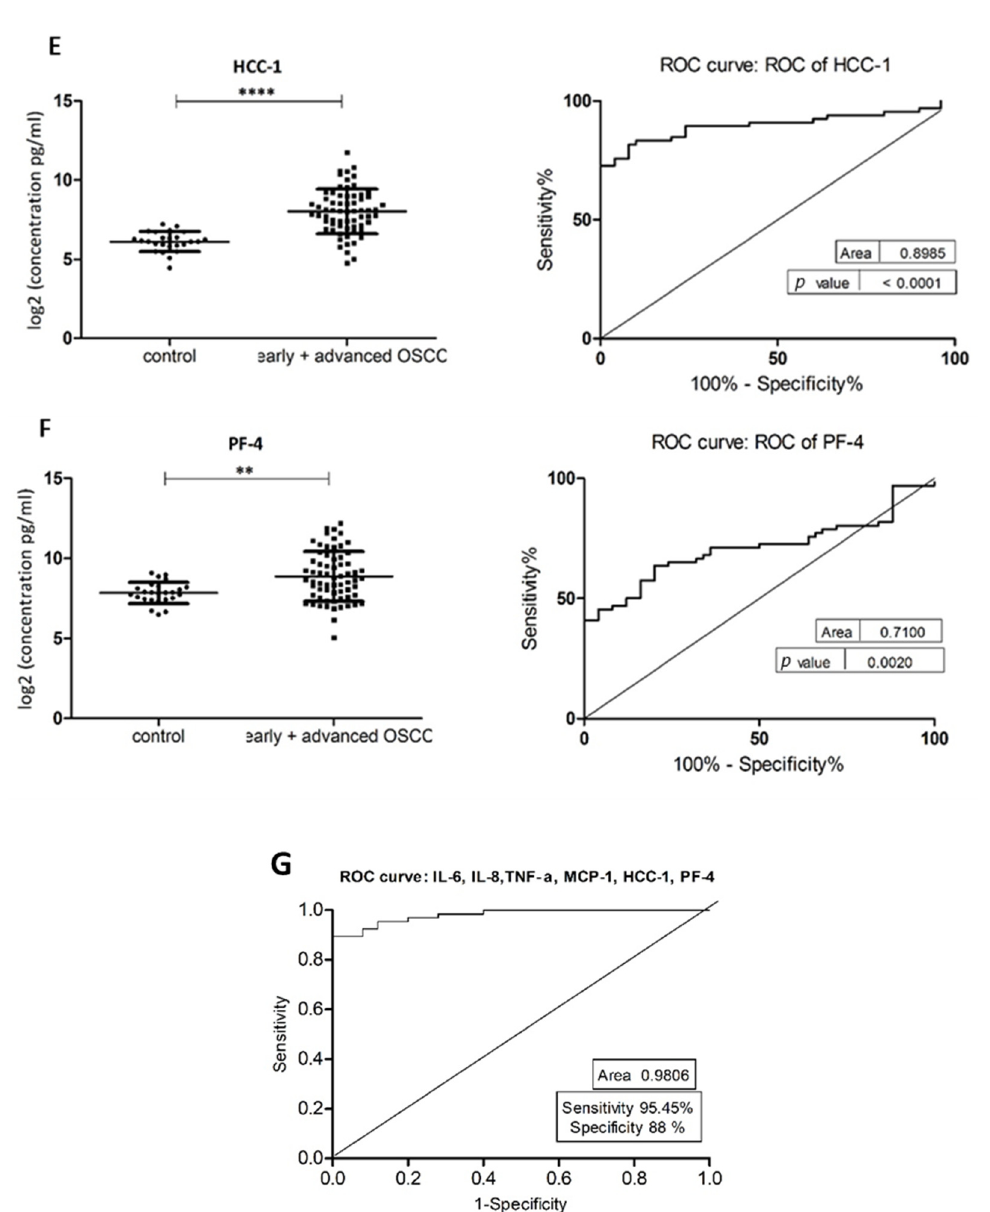
Figure 2. Comparison of salivary cytokine levels between control individuals and OSCC patients. Dot plot of significantly different log2 levels (pg/mL) (left) and ROC curve (right) of ( A ) IL-6, ( B ) IL-8, ( C ) MCP-1, ( D ) TNF- α , ( E ) HCC-1 and ( F ) PF-4 ( p ≤ 0.0001 ****, 0.0001 ****, 0.01 *, 0.0001 ****, 0.0001 **** and 0.002 **, respectively). ( G ) ROC curve combining multiple markers, including IL-6, IL-8, TNF- α , MCP-1, HCC-1, and PF-4. Values represent mean ± SD of n = 25 (control) and n = 66 (early + advanced OSCC stages), where n is an average of two technical replicates.